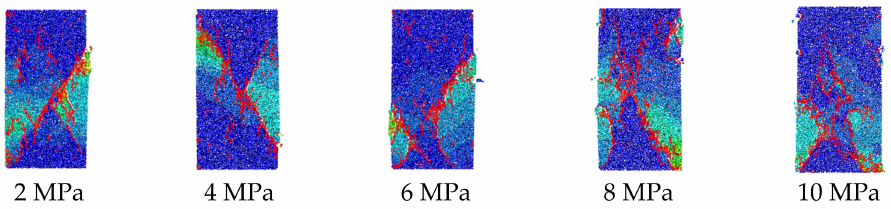
Figure 15. Crack diagrams of the stone powder-cement grout slurry under different curing pressures.